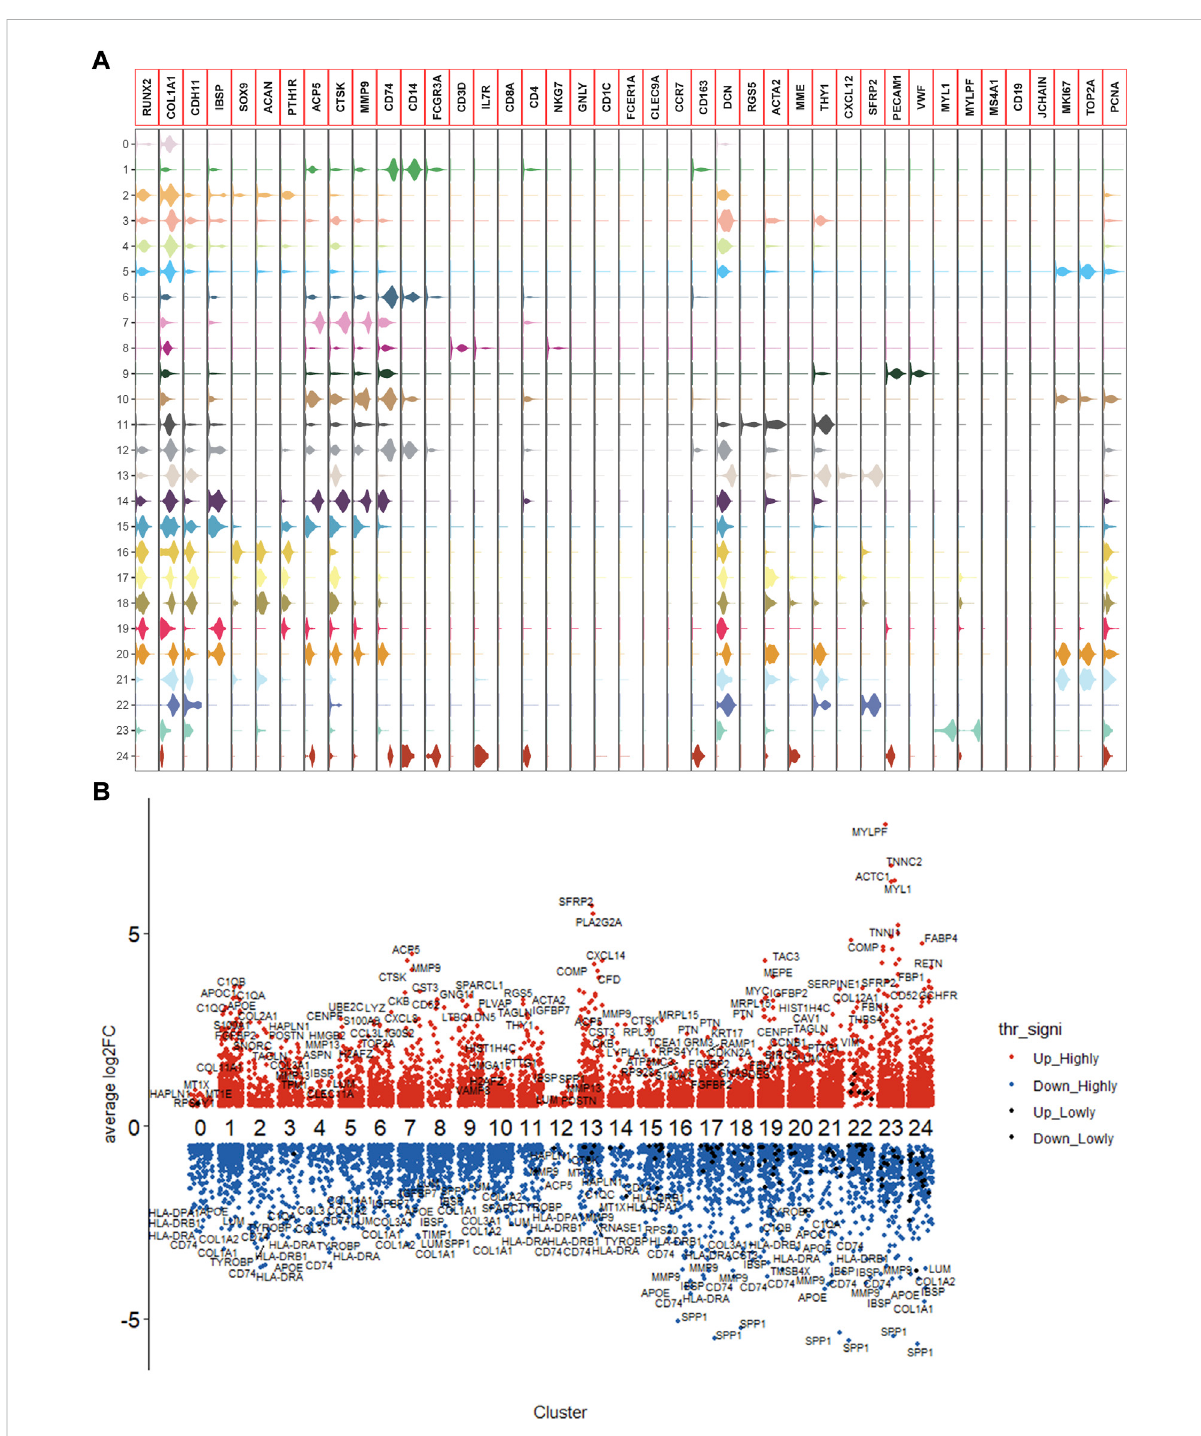
FIGURE 2 Expression of marker genes in the OS. (A) : violin plot of marker genes. (B) : columnar scatter plot of